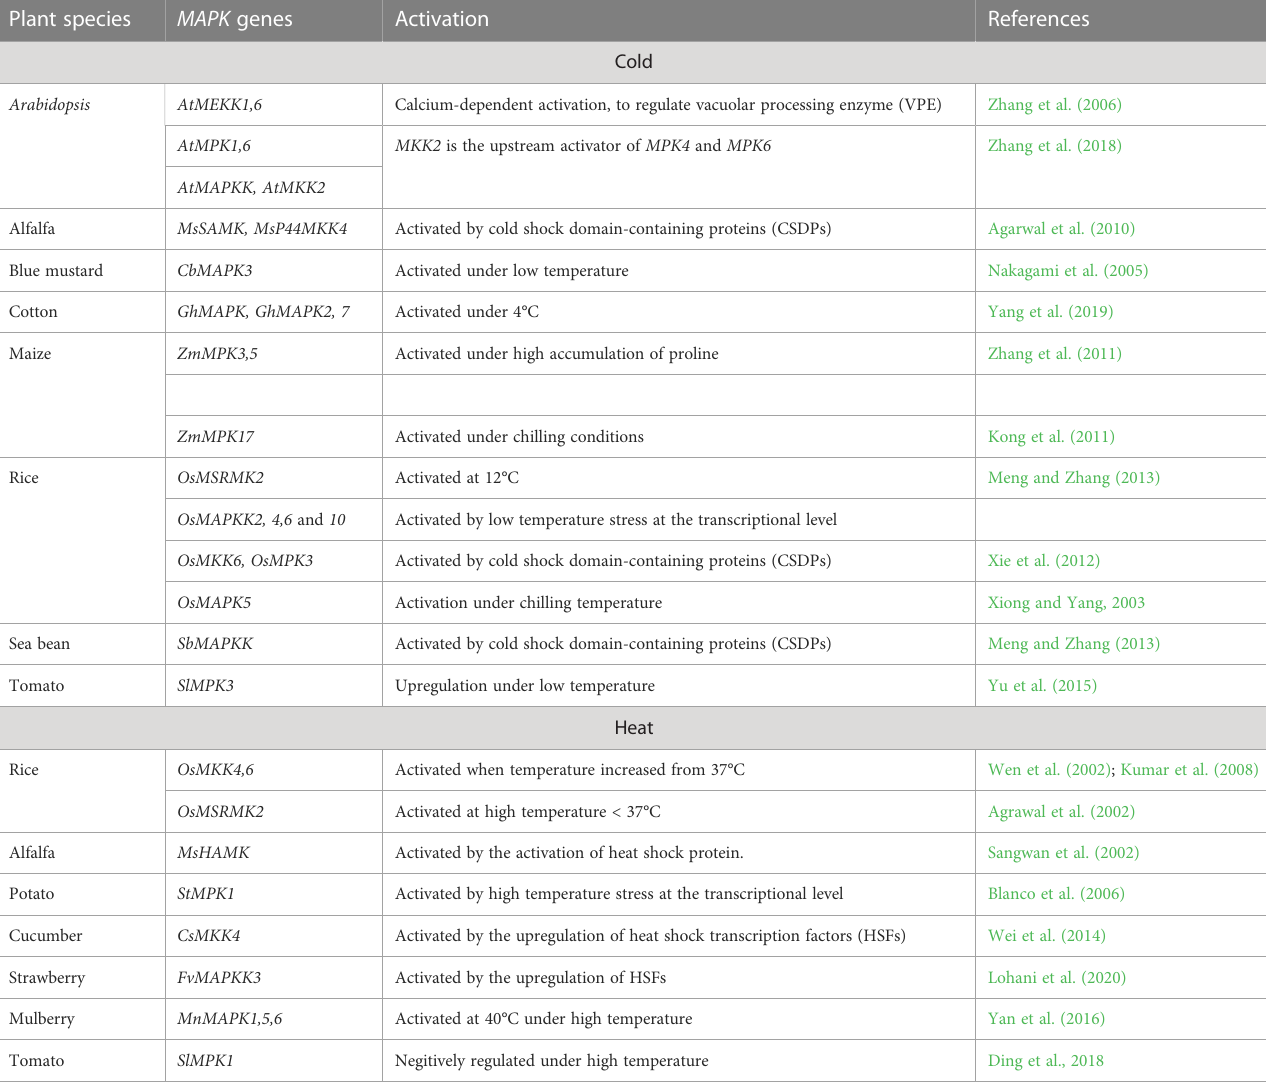
TABLE 3 MAPK gene signaling responses in different plants under cold and heat stress conditions. Plant